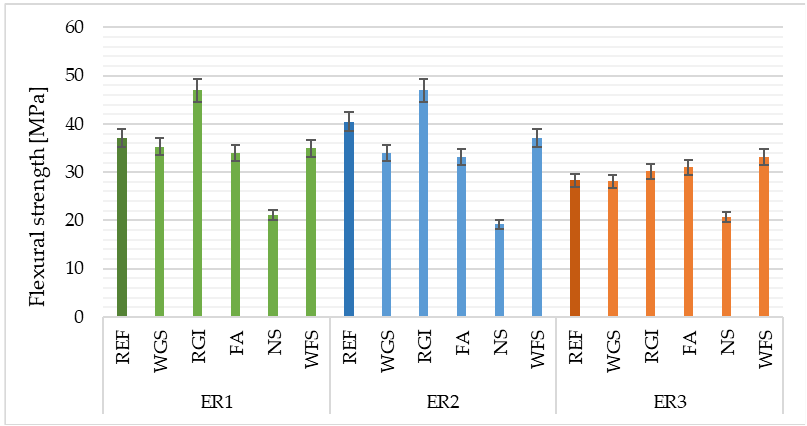
Figure 6. Flexural strength of epoxy composites depending on the type of filler and epoxy binder used.